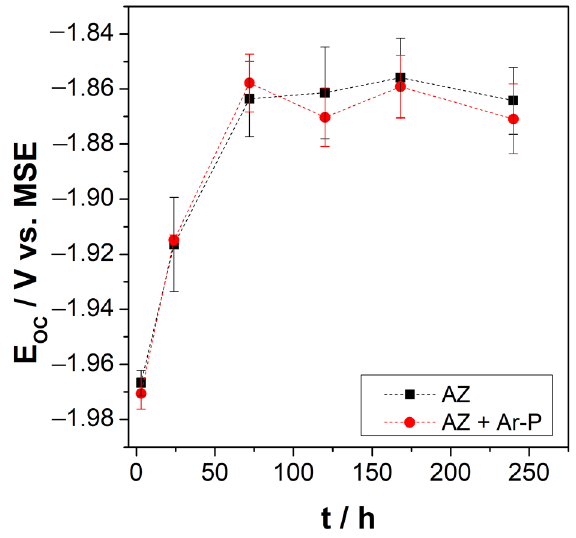
Figure 3. Open circuit potential of AZ31 surfaces (before and after pretreatment) as a function of immersion time in Na 2 SO 4 0.1 M. ( ■ ) AZ and ( • ) AZ + Ar-P samples.